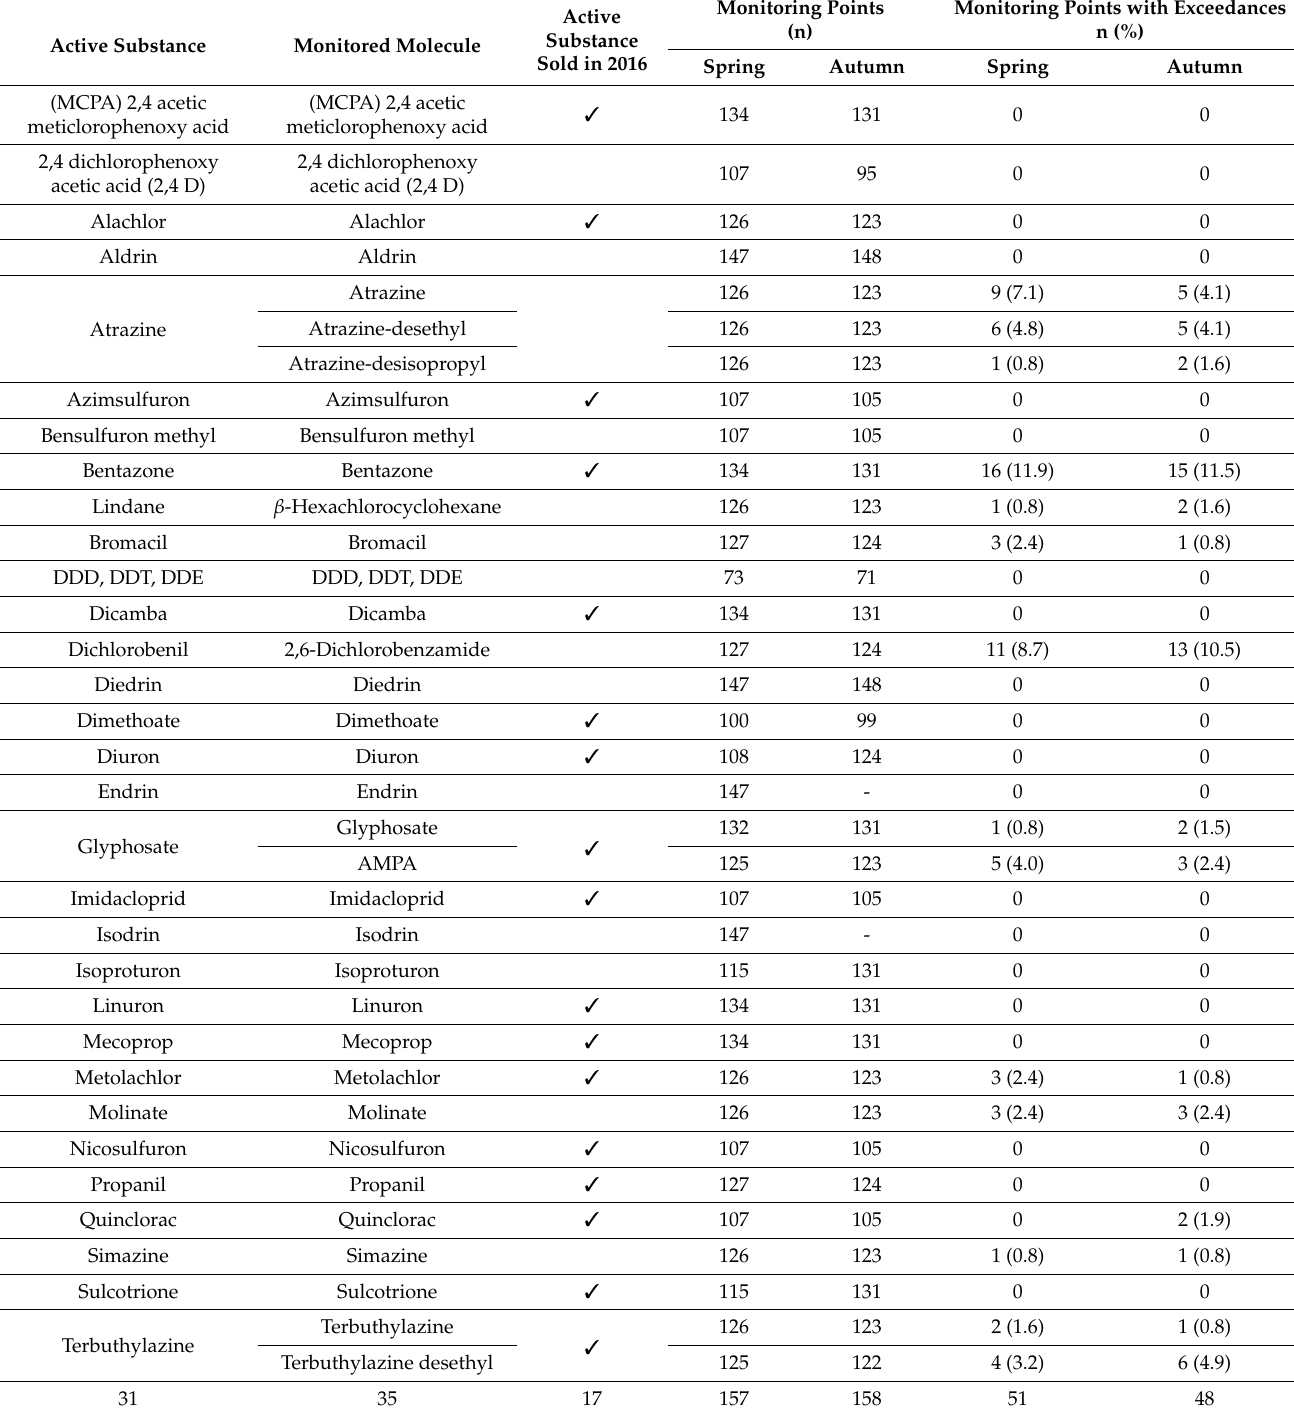
Table 4. Summary of official controls of groundwater in Lombardy by ARPA in 2016. List of the active substances and of the molecules monitored, with the identification of those sold in the year 2016. Number of monitoring points and number and percentage of monitoring points in which at least one exceedance of the EQS single was found, in the spring and autumn